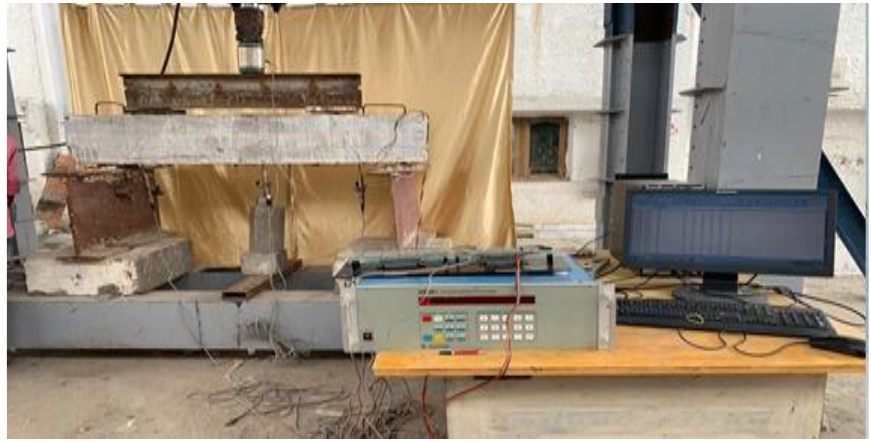
Figure 4. Beam experimental setup.